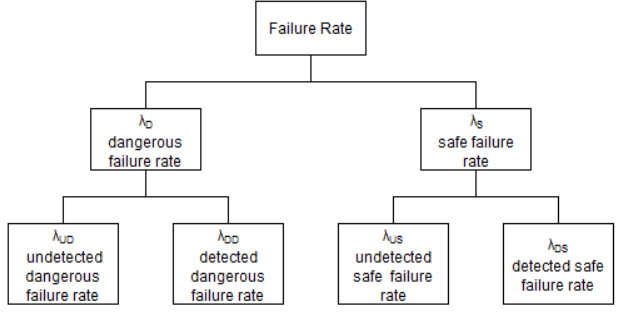
Fig. 2. SIS failure rate